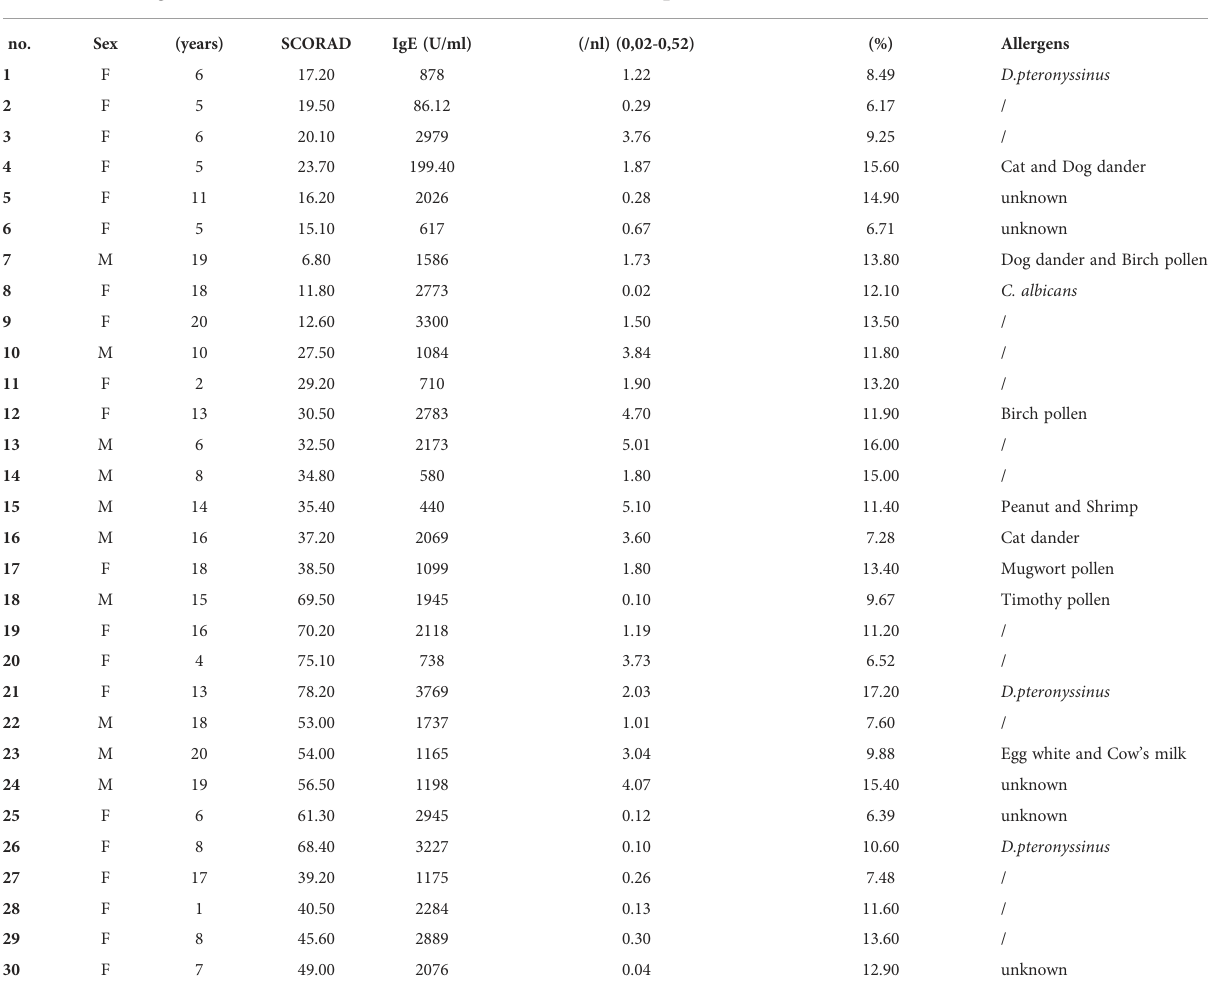
TABLE 1 Characteristics of patients with atopic dermatitis in the present study. Patient Age at onset